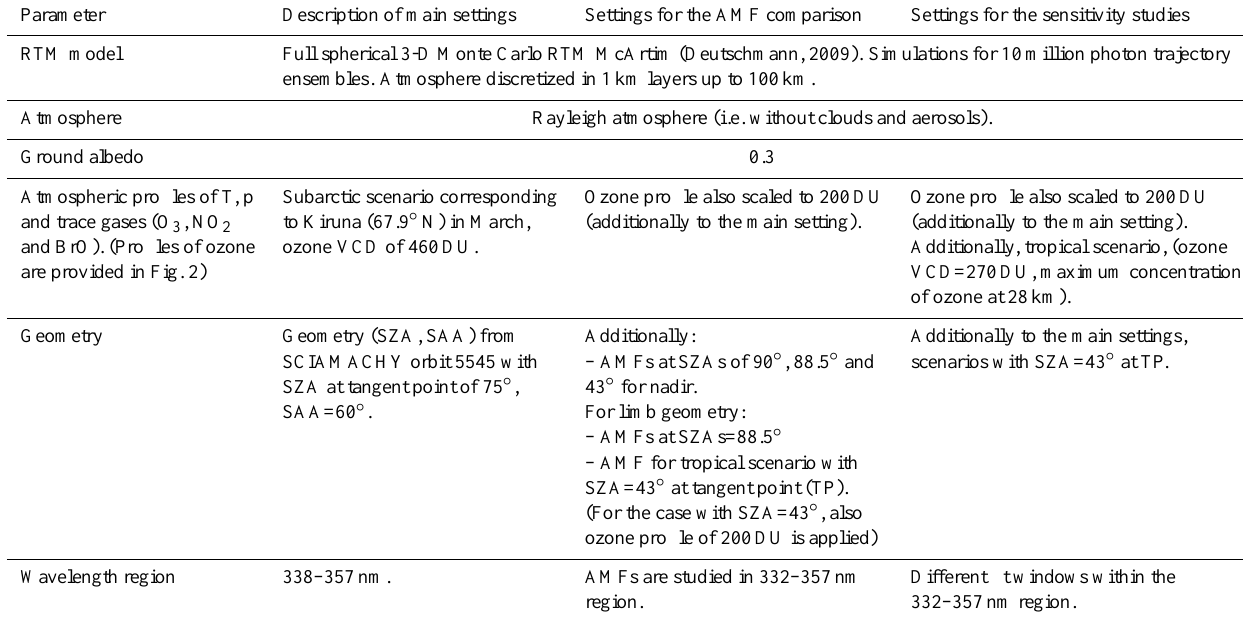
Table 1. Parameters used for the simulation studies.